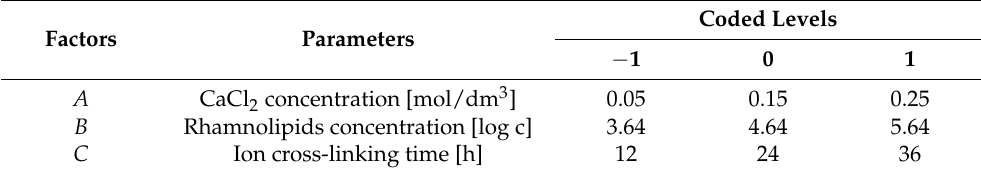
Table 1. Range and levels of parameters in Box-Behnken experimental design.